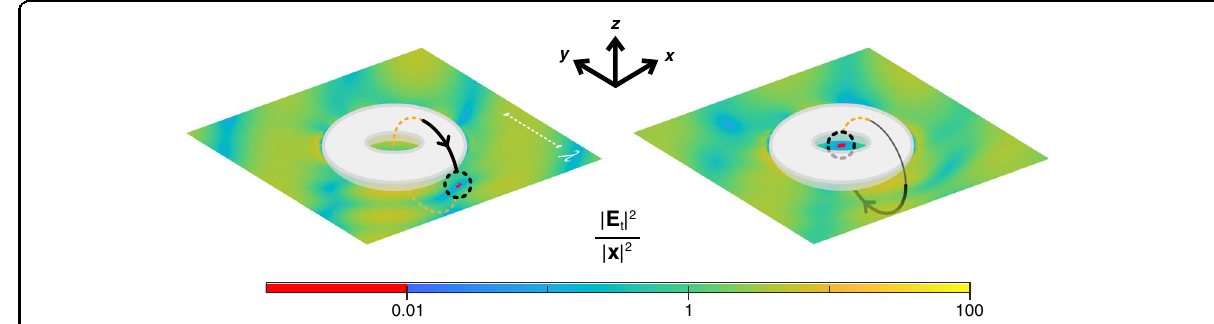
Fig. 3 Moving a cold spot around a silver torus in simulations Results obtained for a torus particle, via numerical simulations. The intensity enhancement on the xy plane containing a cold spot, moved along a circular path (angled into the page) by the polarisation, relative intensity and phase of two plane waves with λ ¼ 800 nm, is plotted at two stages in the cold spot ’ s journey. The complete cold spot trajectory is animated in the supplementary